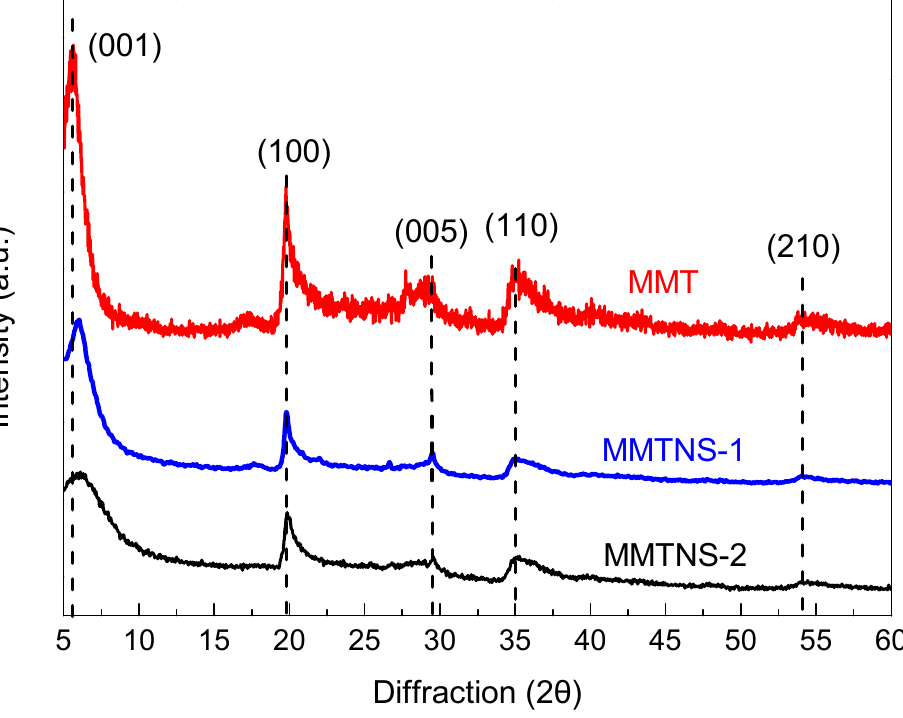
Figure 2. XRD patterns of montmorillonite (MMT), MMTNS ‐ 1, and MMTNS ‐ 2.